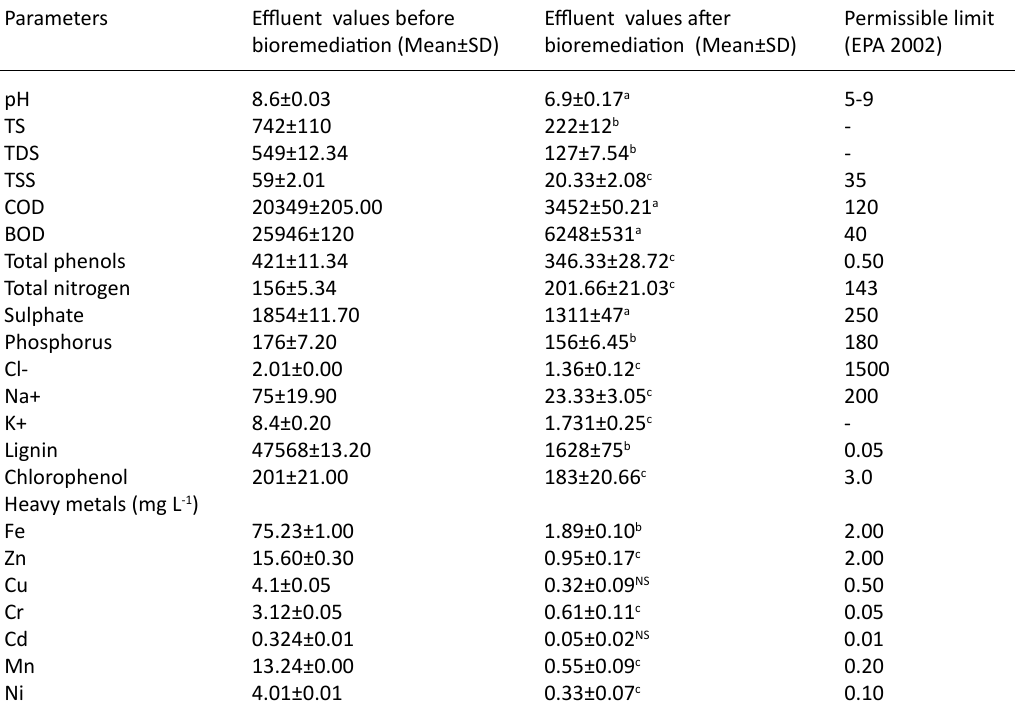
Table 1. Physico-chemical characteristics of pulp paper mill effluent and their heavy metals content. All the values are Mean±SD. (n=3), Students t test (two tailed as compared to pre-treated wastewater). a Highly significant at p<0.001, b Significant at p<0.01, c Less significant at p<0.05, NS Non-significant at